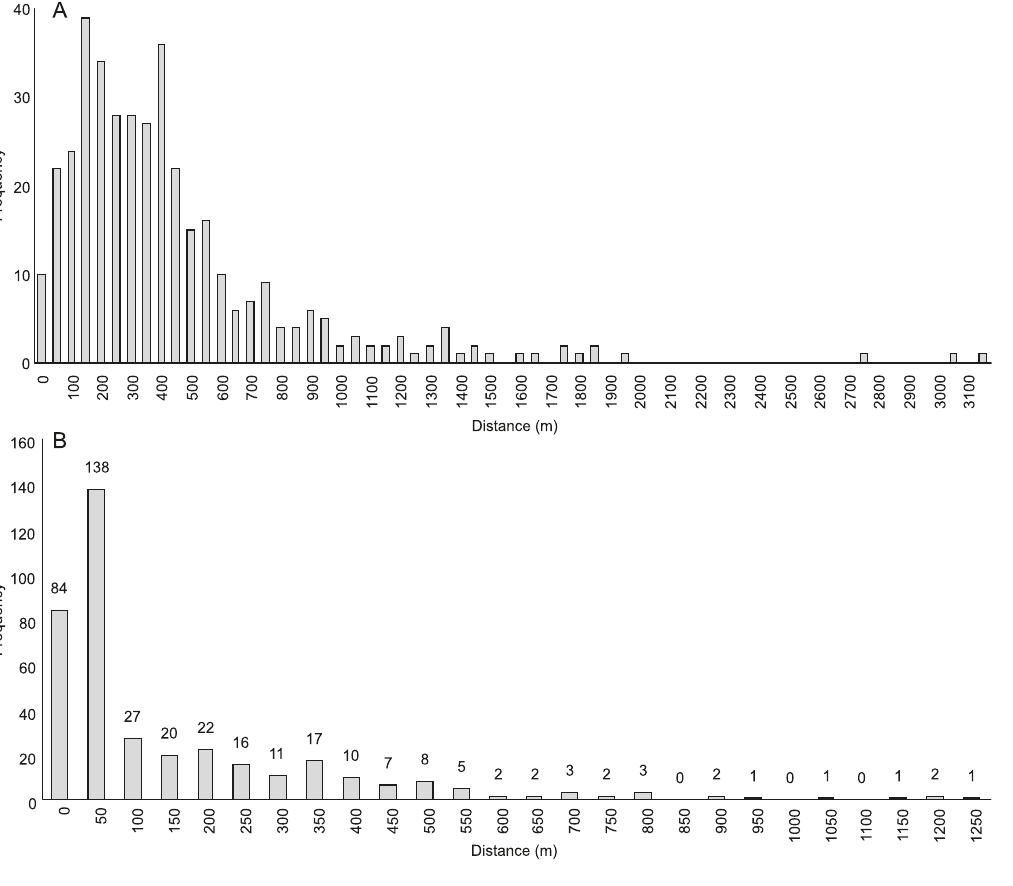
Figure 2. Histograms of distances from moose-vehicle collisions (MVCs) against the built-up footprint ( A ) and forest cover ( B ) in Lithuania. Digital 1:10,000 topographic maps of the country (https://www.geoportal.lt/geoportal/nacionaline-zemes-tarnyba-prie-zemes-ukio-ministerijos) were used to define buildings/dwellings footprints.